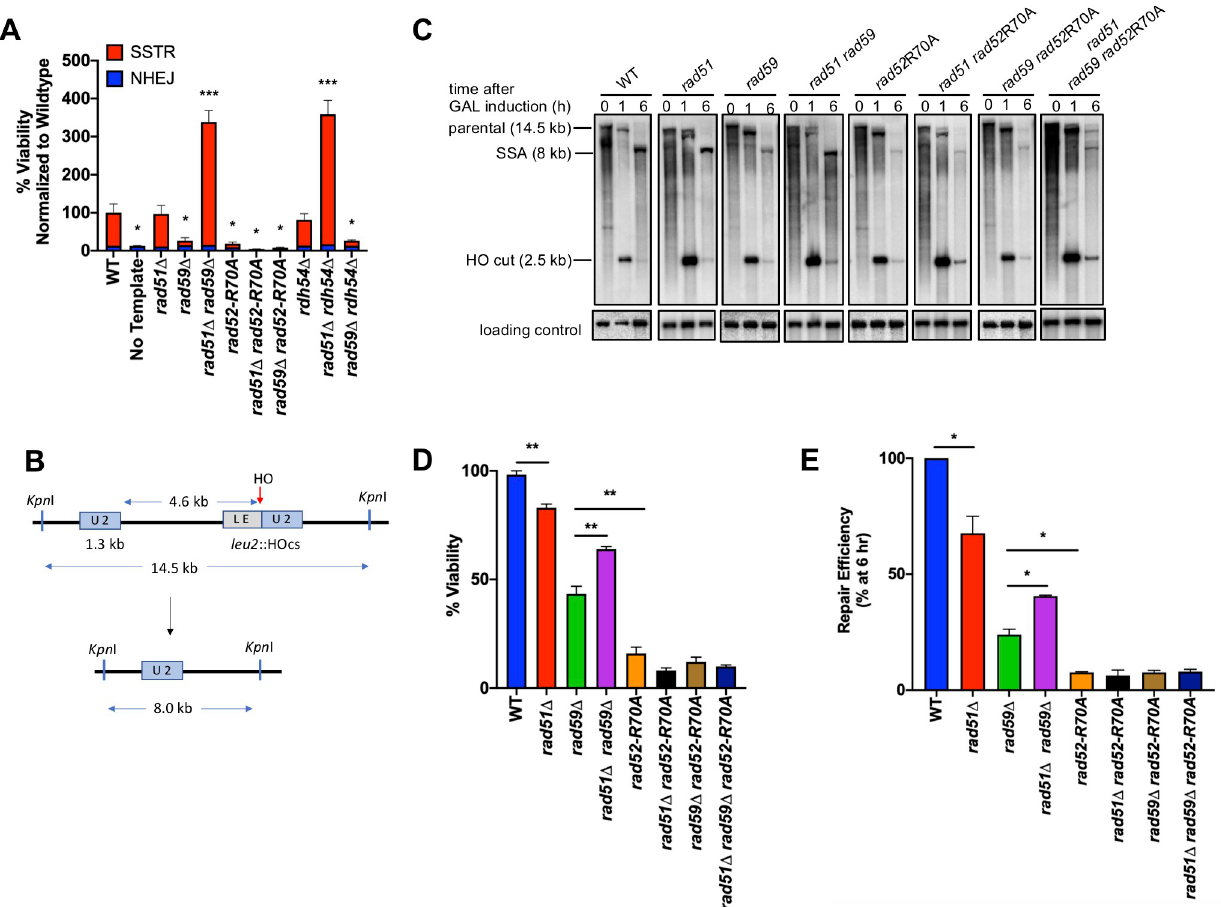
Fig 2. Rad59 alleviates the inhibition of Rad51 on annealing activity of Rad52. A) Viability of single and double mutants following SSTR, determined by plating on galactose-containing media. B) An HO-induced DSB results in repair via SSA between partial leu2 gene repeats located 5 kb apart on the left arm of chromosome 3. C) Representative southern blots showing DSB repair products by SSA in WT and indicated mutants. D) Viability of mutants on galactose-containing plates, where HO DSBs are repaired via SSA (mean ± SD; n = 3). Welch’s t-test was used to determine the p-value. E) Graphs show quantitative densitometric analysis of repair efficiency by 6 hr compared to WT (mean ± SD; n = 3). Welch’s t-test was used to determine the p-value.